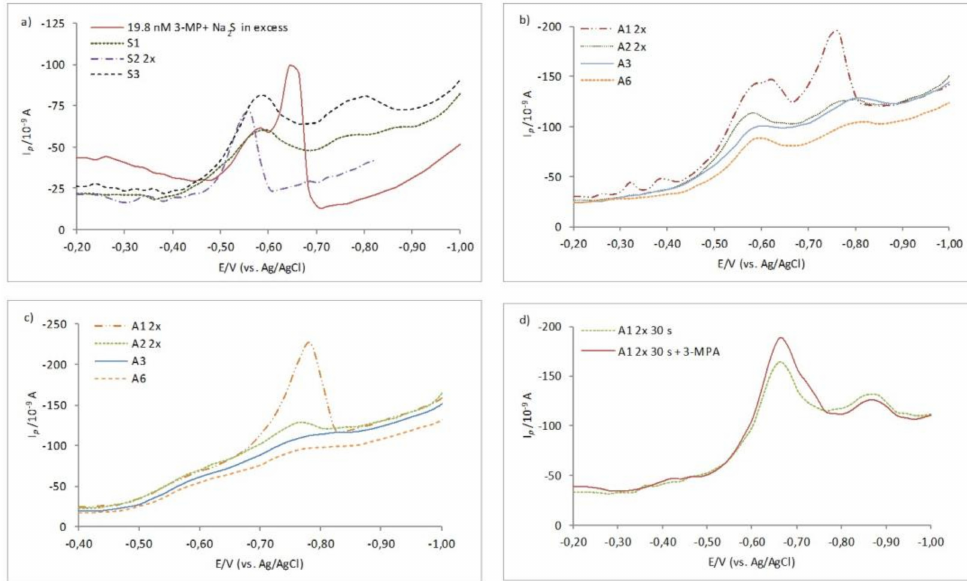
Figure 4. CSSWV curves recorded in the WS fraction of ( a ) three consecutive Spring 2016 aerosol samples (S1, S2, and S3). Red-solid line corresponds to CSSWV scan of the electrolyte containing 19.8 nM 3-MPA spiked with Na 2 S; ( b ) four consecutive Autumn 2016 aerosol samples (A1, A2, A3, A6); ( c ) e ff ect of di ff erent deposition potential (E d = − 0.4 V) for Autumn samples A1, A2, A3, A6. t a = 120 s for a – c ; ( d ) addition of the standard 3-MPA in Autumn sample A1, after the